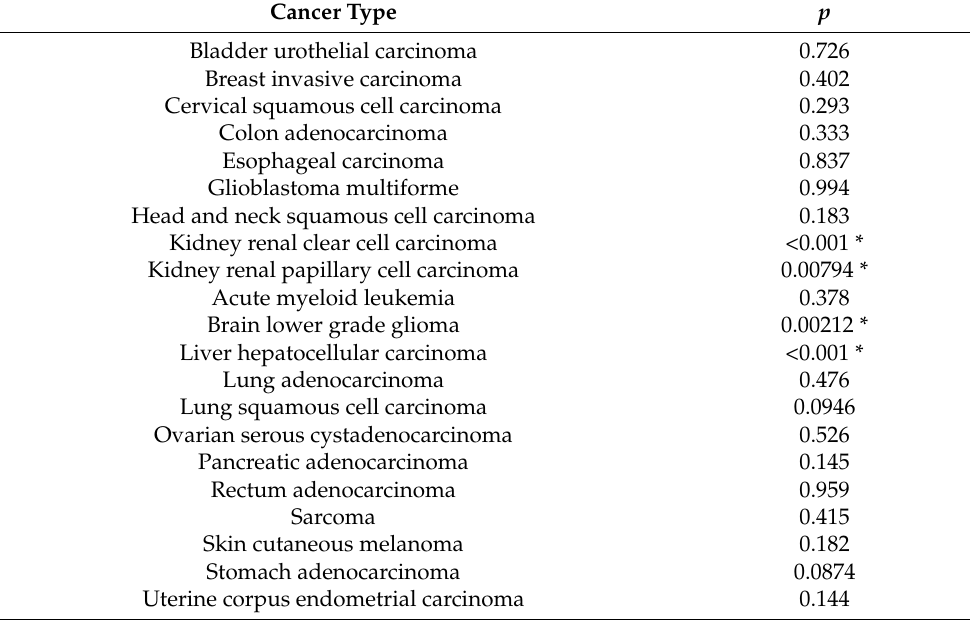
Table 2. Statistical significance of prognostic value of EZH2 in various cancer types.